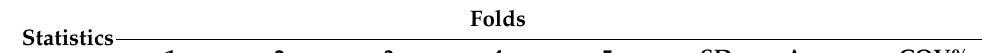
Figure 5. Results for five-fold cross validation. Table 3. Cross-validation measurement results. Table 4. Cross-validation measurement results.